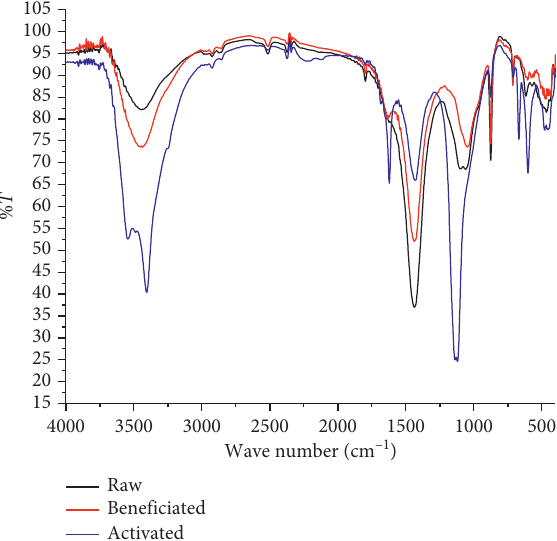
Figure 4: FTIR spectra of raw, beneficiated, and activated